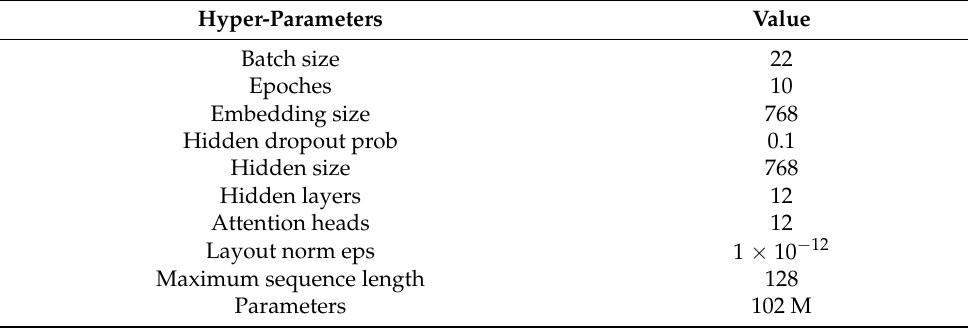
Table A2. Hyper-parameters of the fine-tuned